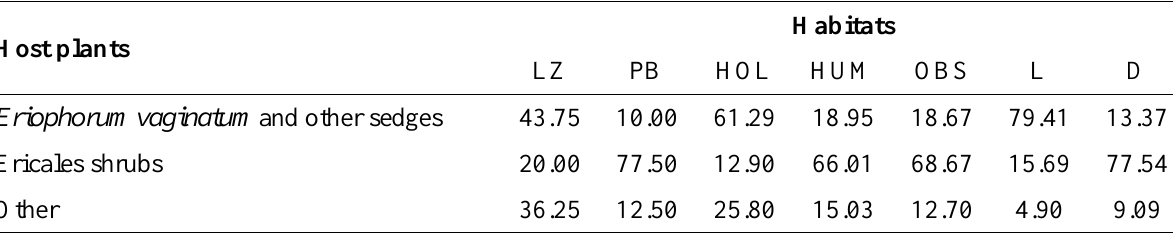
Table 4. Differences (relative abundance, %) in the trophic preferences of herbivorous beetles occurring in different habitats on the Yelnia peat bog. Habitat symbols: LZ = lagg zone; PB = pine bog; HOL = hollow; HUM = hummock; OBS = open bog space; L = lakeshore; D =